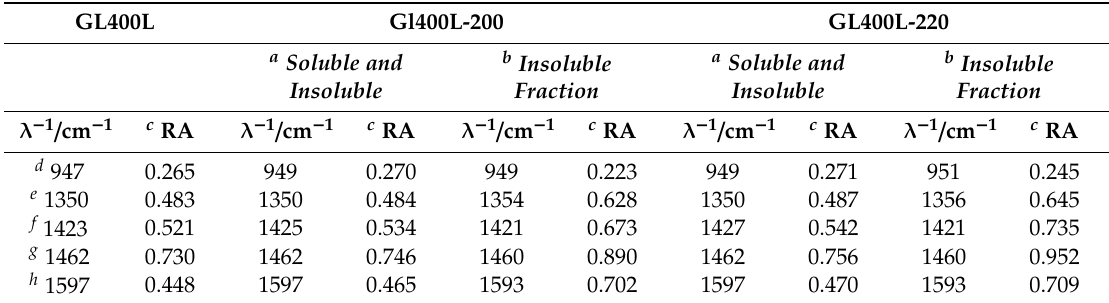
Table 2. ATR-FTIR spectral data for GL400L, heat-treated GL400L-200 and GL400L-220.